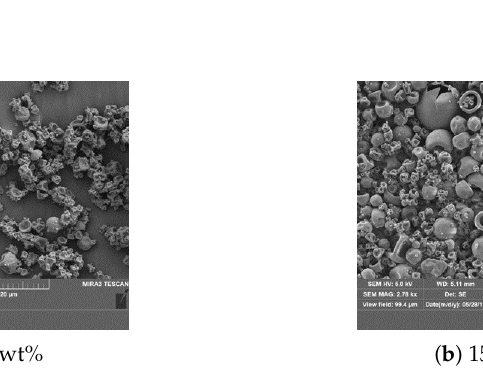
Figure A9. Effect of total solids concentration in feed solution. The percent values below each image indicate the weight percent of total dissolved solids (protein + excipient) in buffer. Both systems were spray dried from feed solutions containing unfunctionalised medium-sized silica NP excipient (D h , water = 16 ± 1 nm) in pH 5.5 buffer. Table A1. Particle Size and Morphology 1 .